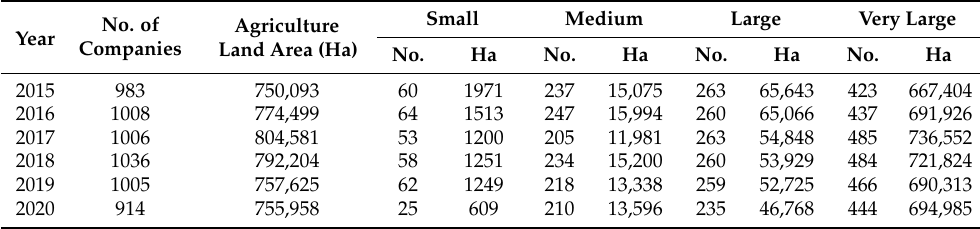
Table 2. Number of farms in the research sample and their acreage of agricultural land.